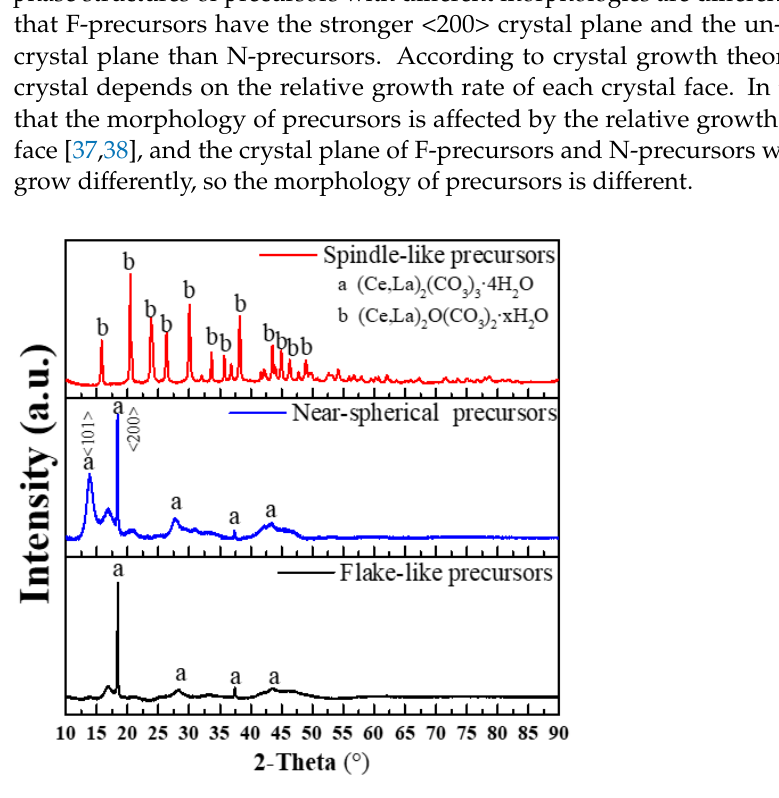
Figure 3. XRD diffraction patterns of different precursors.